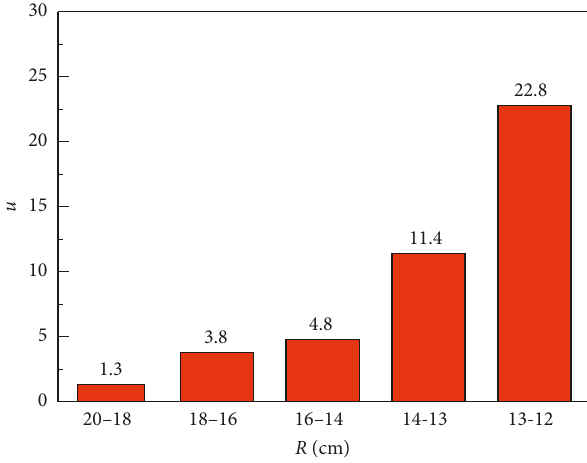
Figure 11: Depression area volume changes with the stand-off